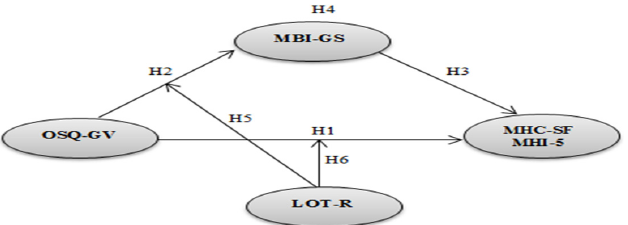
Figure 1. The theoretical framework. Note. OSQ—GV (Occupational Stress Questionnaire—General Version); MBI-GS (Maslach Burnout General Inventory Scale including exhaustion, cynicism, and professional efficacy); LOT-R (Revised Life Orientation Test), MHC—SF (Mental Health Continuum—Short Form including psychological, emotional and social well-being); MHI-5 (Five-item Mental Health Inventory including anxiety and depression).